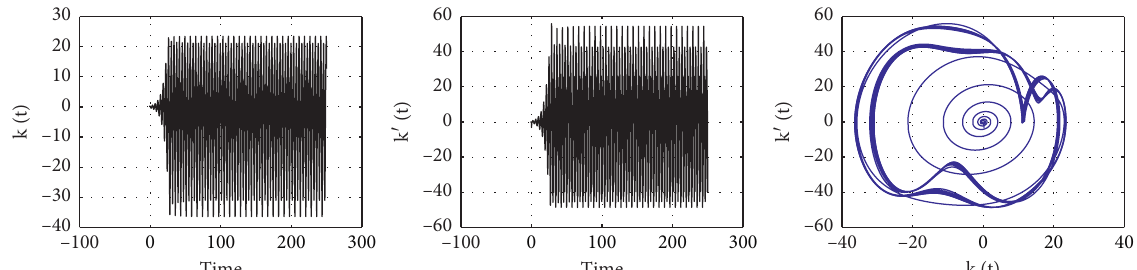
Figure 15: Solutions and phase trajectories at a � 0.125, q � 0.75, and τ � 1.5.